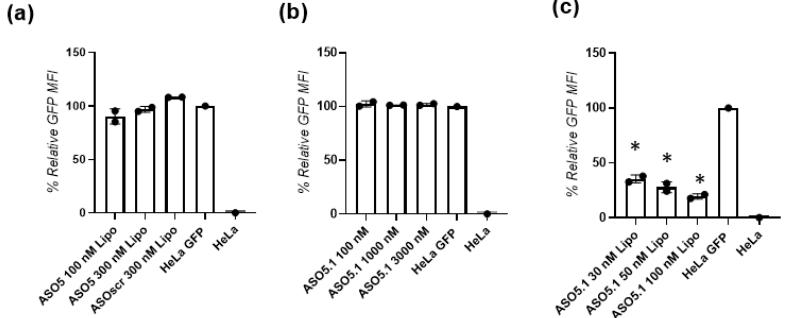
Figure 2. Relative GFP fluorescence in GFP-expressing HeLa cells. Transfection was performed ( a,c ) with lipofectamine (Lipo) or ( b ) without. GFP expression was assessed measuring the median fluorescence intensity (MFI) 48 h post transfection with the ASOs by flow cytometry. Error bars indicate standard deviation (SD) of at least two independent biological replicates. * p < 0.05 versus HeLa GFP calculated by one-way ANOVA.